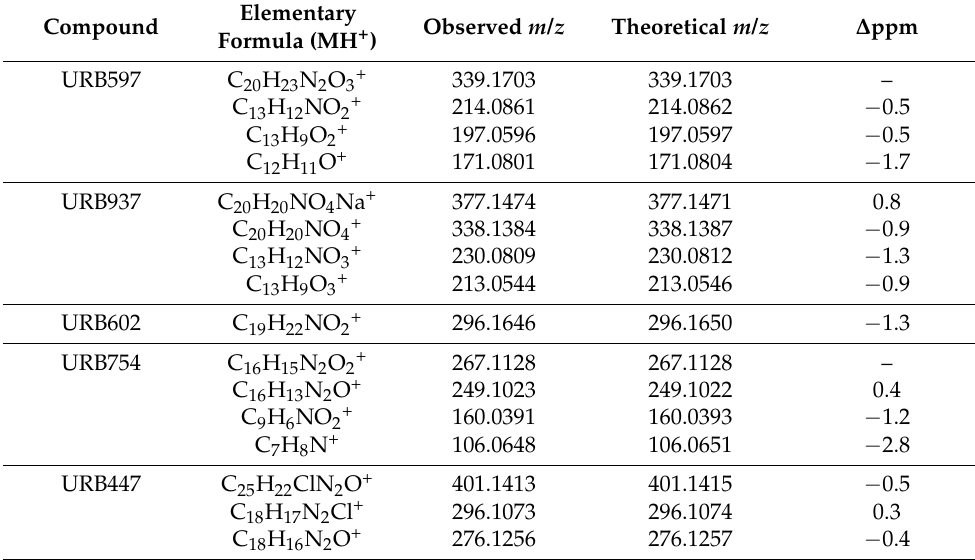
Table 2. HRMS of protonated molecules and CID-induced fragment ions.